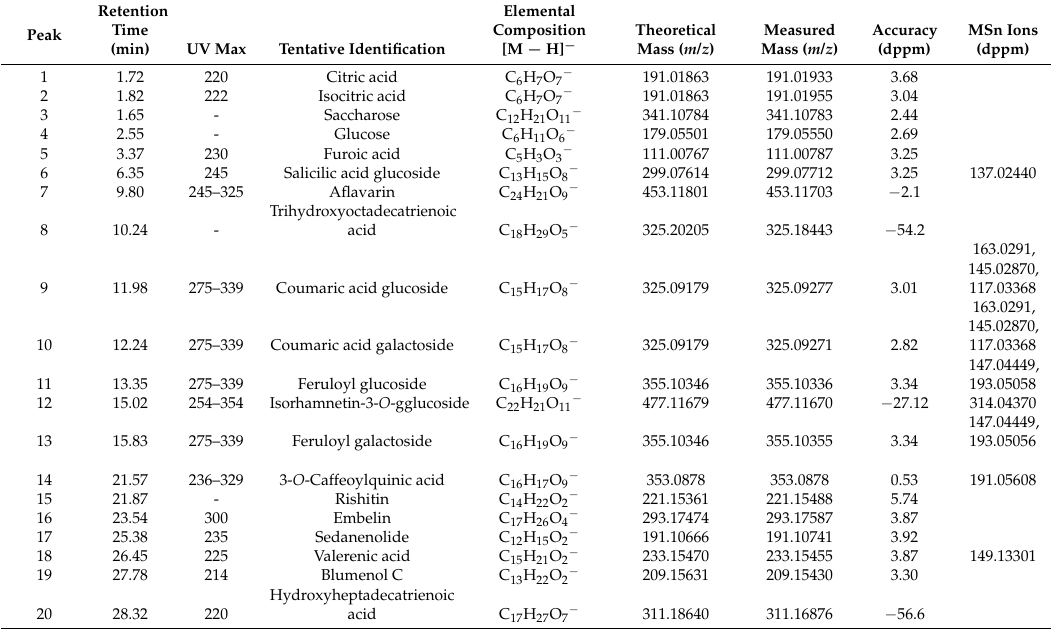
Table 4. Identification of metabolites by